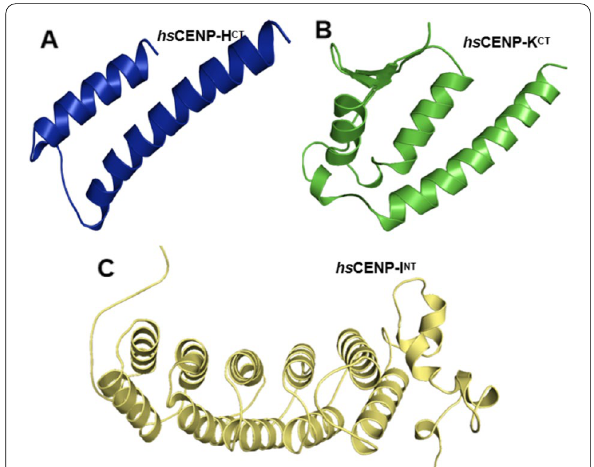
Fig. 1 Predicted 3D models of the human CENP-H (blue), CENP-I (pale yellow) and CENP-K (green) showing close similarity with X-ray crystal structures of fungal (PDB 5Z08) and yeast (PDB 6YPC)